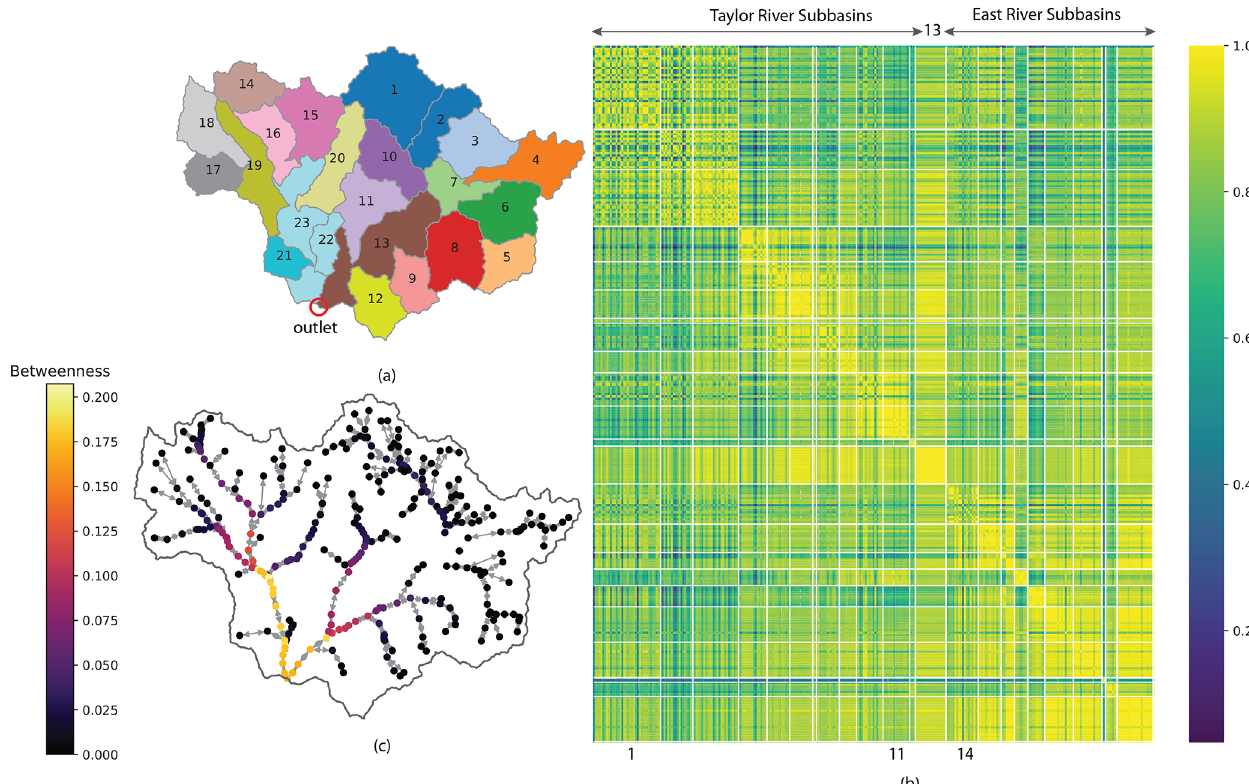
Figure 6. Node correlation heatmap generally exhibits a block structure within subbasins: (a) subbasin boundary map, where subbasins 1–13 are on the Taylor River side and subbasins 14–23 are on the East River side; (b) node correlation heatmap, where solid white lines separate nodes in different subbasins; (c) node betweenness centrality map